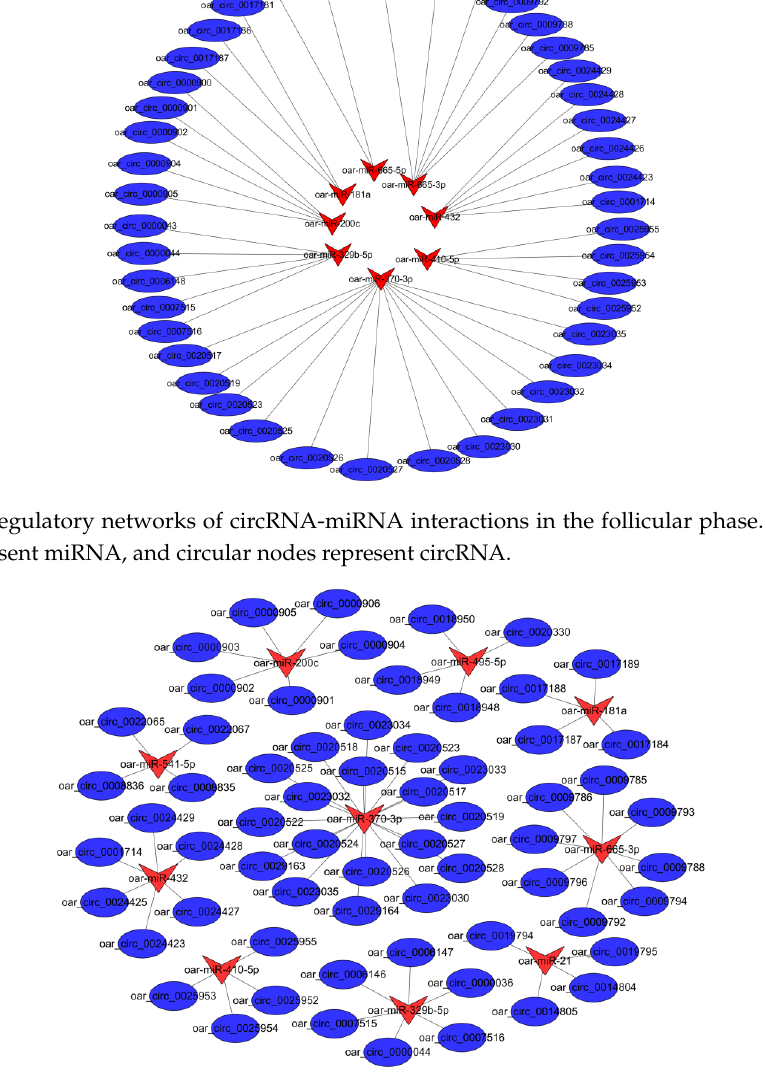
Figure 5. Regulatory networks of circRNA-miRNA interactions in the luteal phase. Triangular nodes represent miRNA, and circular nodes represent circRNA.